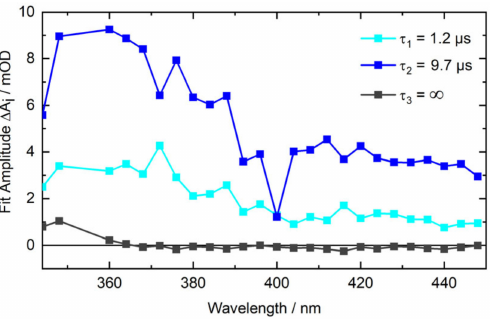
Figure 6. DADS from a multi-exponential global analysis of the nanosecond transient absorption data of 8-MOP with AT-DNA. The time trace at excitation wavelength 355 nm was not included in the